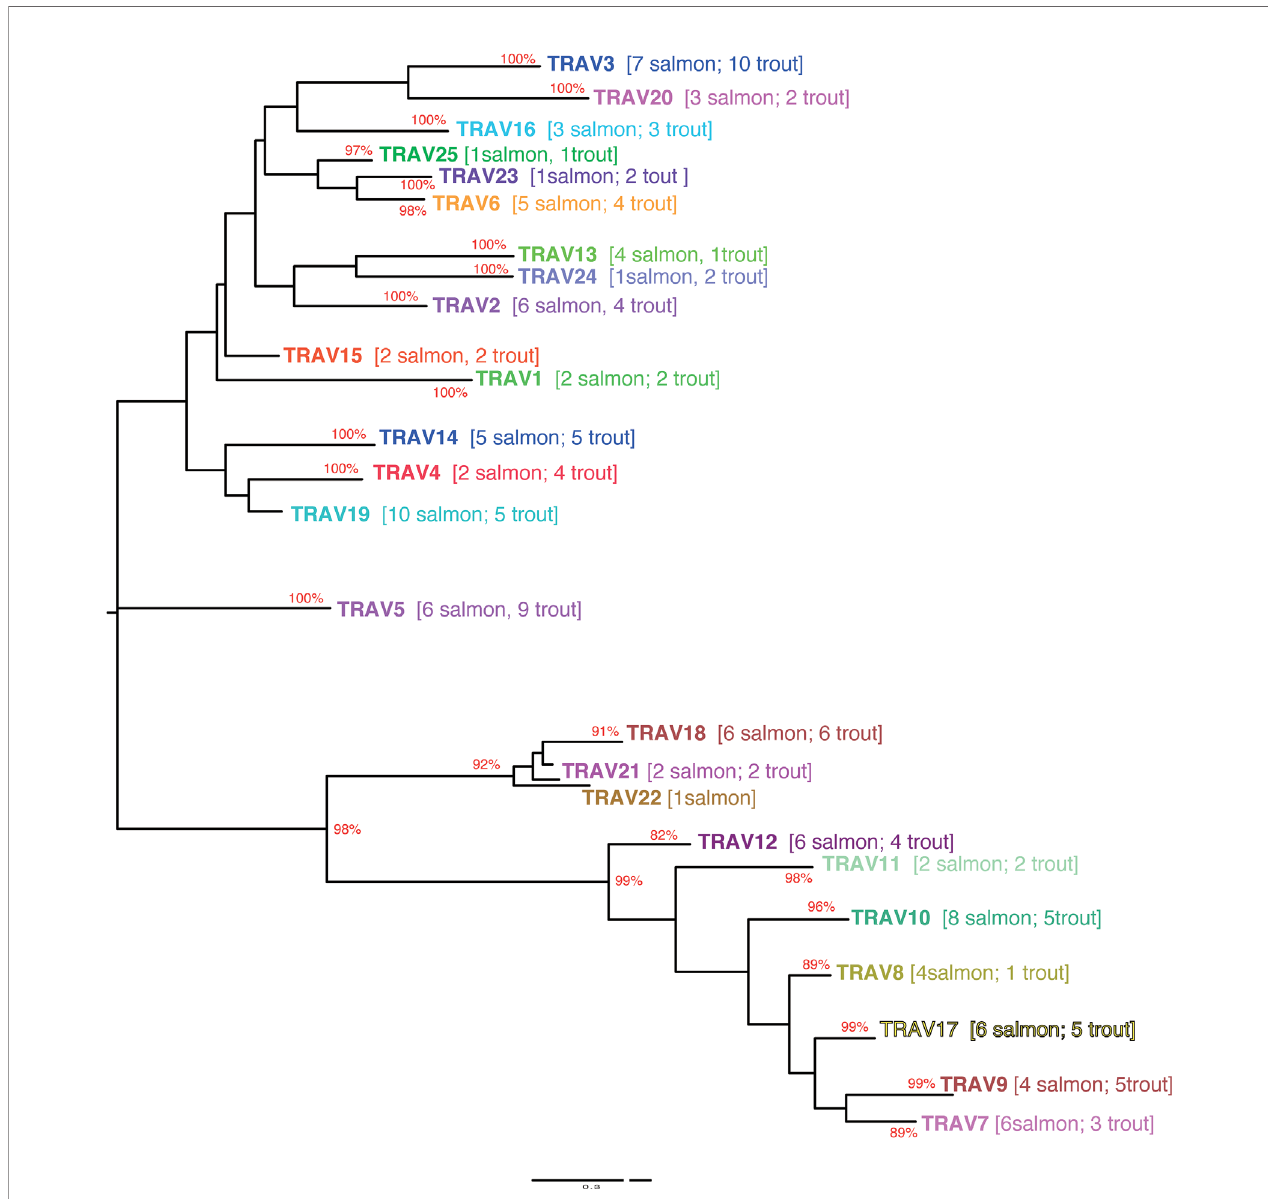
FIGURE 3 | Evolutionary tree of TRAV protein sequences from Atlantic salmon and rainbow trout. The tree was inferred using the Maximum Likelyhood method and JTT matrix based model. A boostrap of 500 replicates was used. The tree with highest likelihood is shown, and is drawn to scale, with branch lengths representing the number of substitutions per site. The percentage of trees in which the associated taxa cluster together is indicated when >80. Subgroups have been collapsed for the sake of readability. The number of Atlantic salmon and rainbow trout sequences in each subgroup is indicated between brackets (an extended tree is represented in Supplementary Figure 4 ). The analysis has been performed only on functional V sequences. Hence it comprises only 25 subgroups since subgroup 26 is only represented by an ORF sequence in the Arlee rainbow trout